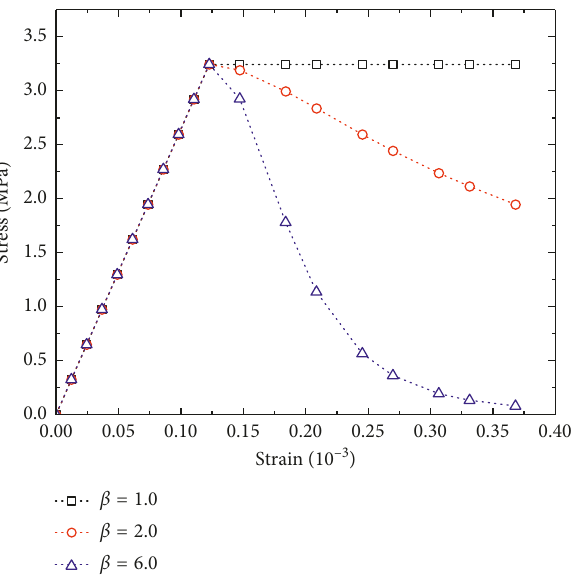
Figure 2: The tensile model of